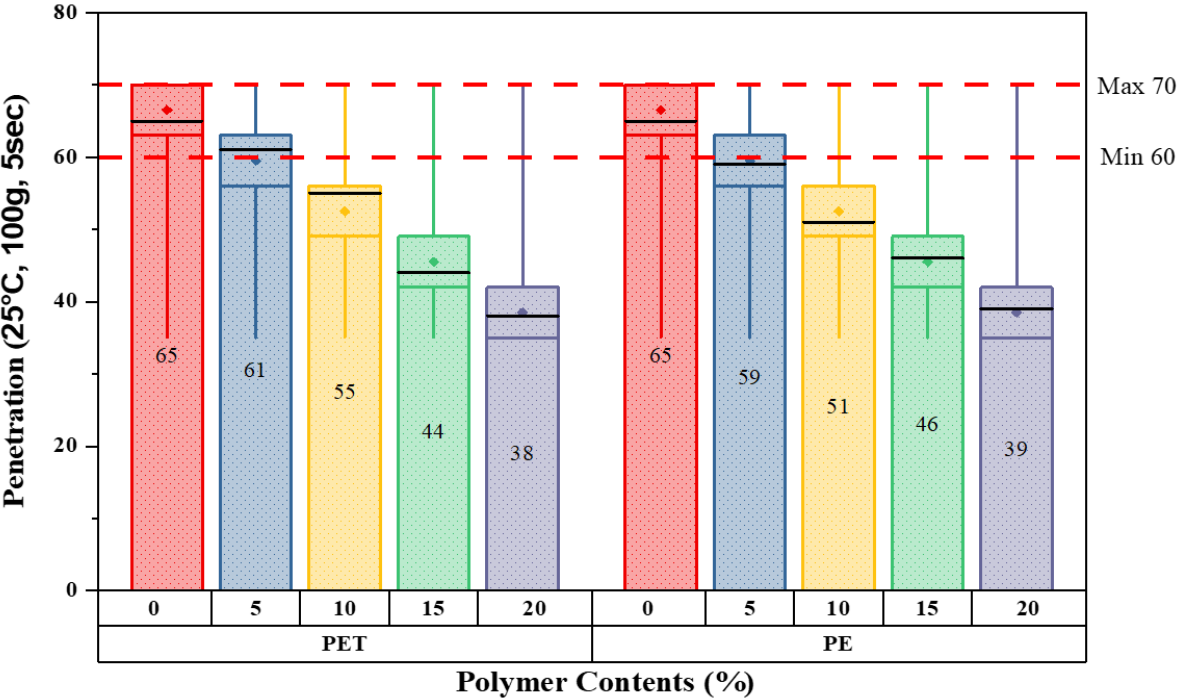
Figure 9. Penetration values with varying plastic content percentages.